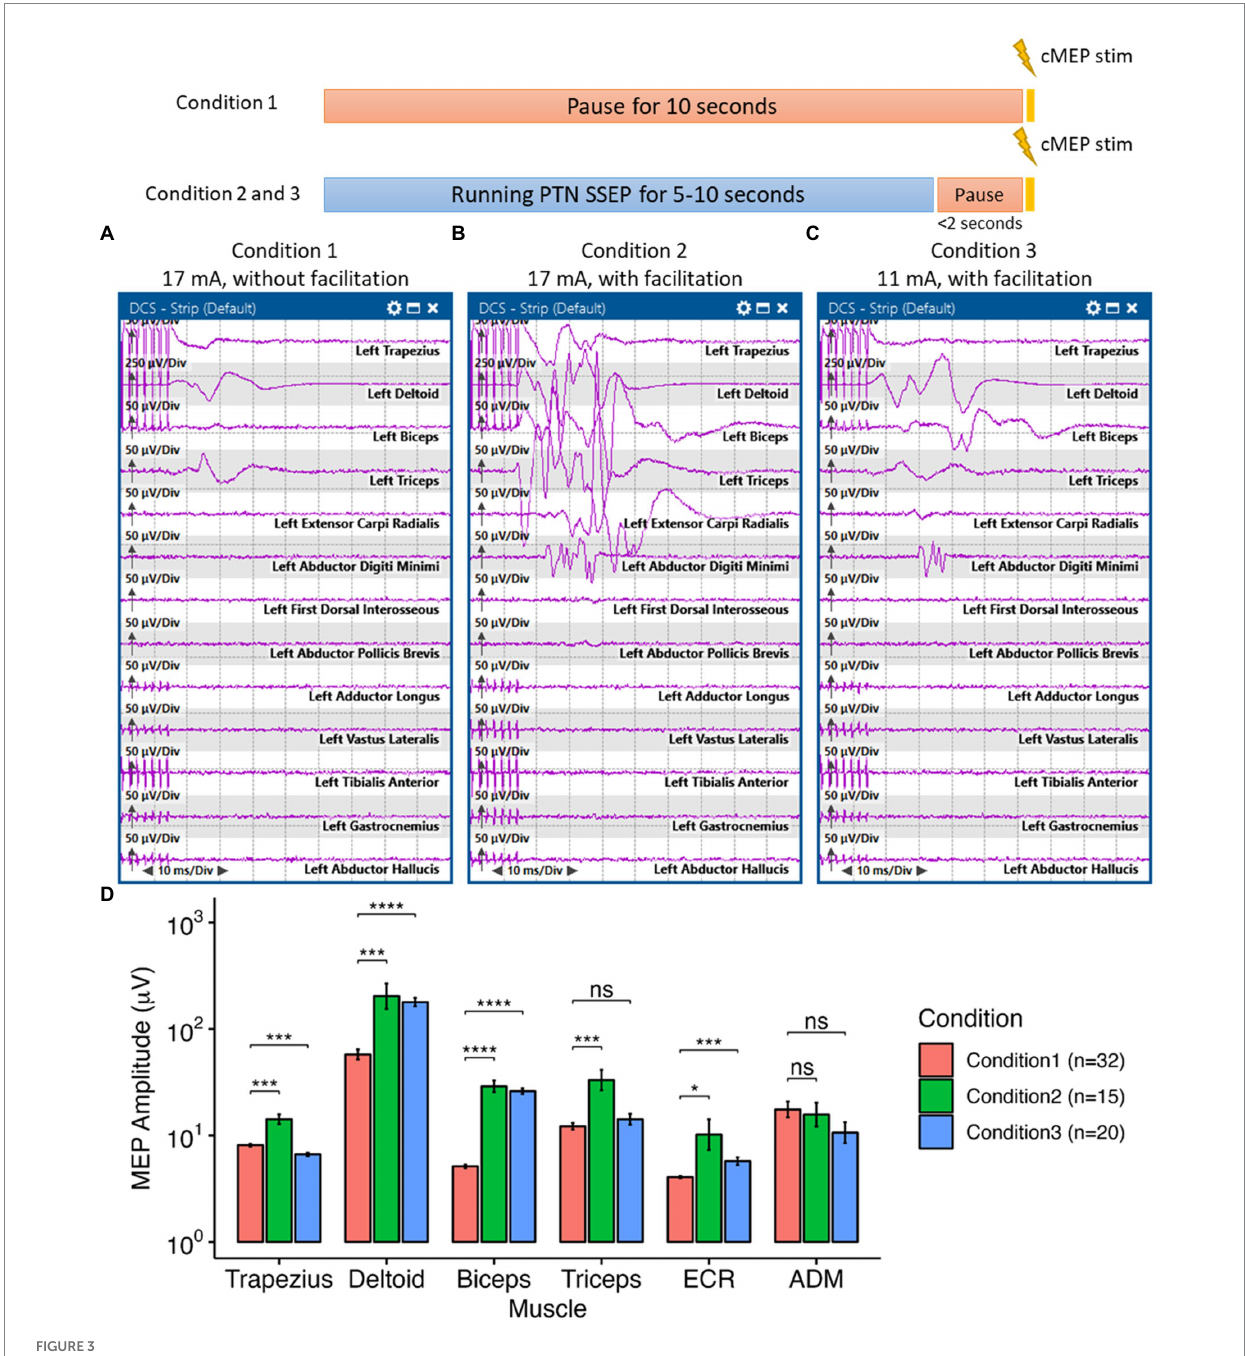
FIGURE 3 Interlimb motor facilitation in the highlighted case. Here, all cortical motor stimulation was delivered with a pulse duration of 300 μ s at 500 Hz every 10 s. Under Condition 1, no other electrical stimulation was delivered to the patient during the 10-s interval. Under condition 2 and 3, posterior tibial nerve (PTN) somatosensory evoked potential (SSEP) was monitored during the 10-s interval, which induced the “facilitation” effect. (A) Without PTN facilitation, we were able to elicit small motor responses on the contralateral shoulder and upper arm by stimulating the cortical surface at 17 mA. (B) With the facilitation effect induced by stimulating the PTN, we were able to obtain greater responses, compared to previous responses, with more complex morphologies on the previously mentioned muscles as well as the forearm and hand muscles by stimulating the same cortical area at 17 mA. (C) The threshold for eliciting contralateral shoulder, arm and hand cortical motor evoked potentials (cMEPs) was reduced to 11 mA with the facilitation effect. (D) The facilitation phenomenon was reproducible and had a significant effect in increasing the amplitudes of the cMEPs in the shoulder, arm and hand muscles. In the ANOVA test to compare the cMEP amplitudes under different conditions, the p- value was less than 0.001. In the pairwise comparison of cMEP amplitudes between conditions for each muscle, a p- value less than 0.05, with Bonferroni correction, was considered significant. ECR: extensor carpi radialis, ADM, abductor digiti minimi. Significance level: ns, not significant, * p < 0.05, ** p < 0.01, *** p < 0.001, **** p <